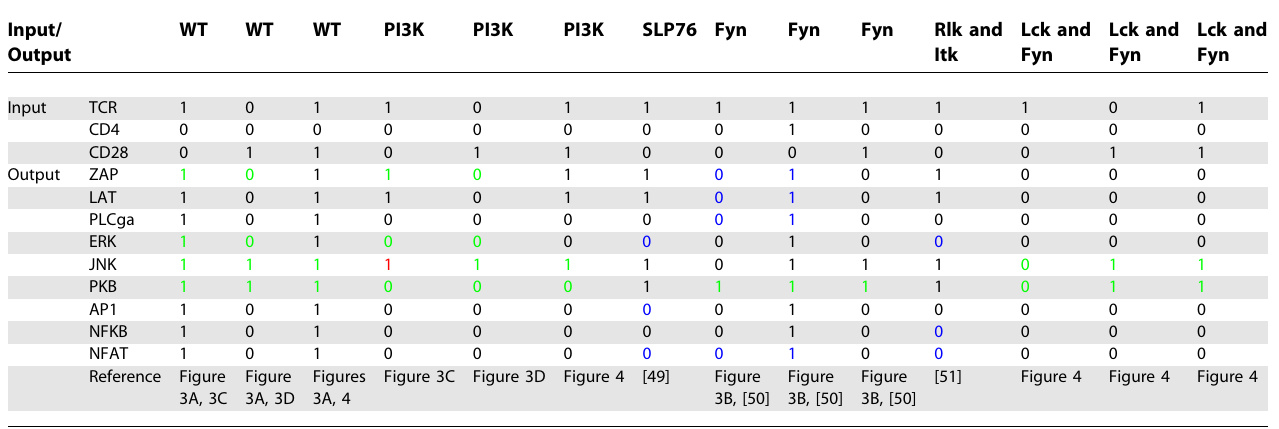
Table 1. Summary of Predicted Activation Pattern upon Different Stimuli and Knock-Out Conditions Input/ Output